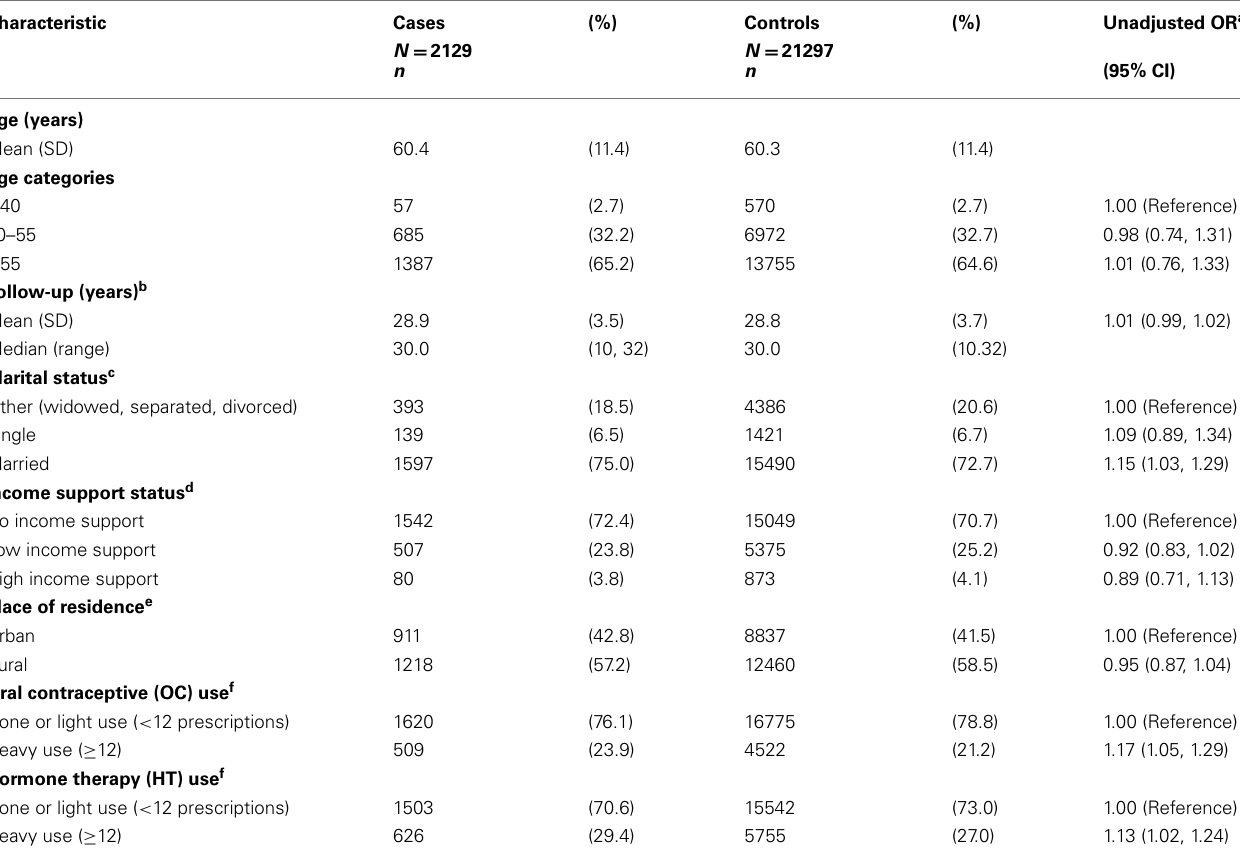
Table 1 | Characteristics of breast cancer cases and age-matched